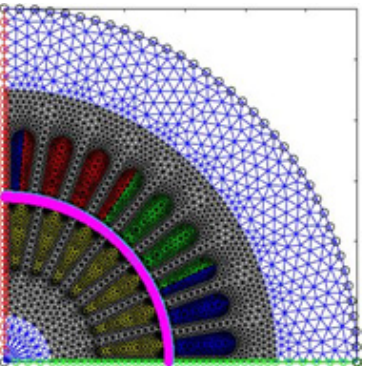
Figure 3. Mesh image of the three-phase squirrel cage induction motor in MATLAB. Table 1. Specifications of the three-phase squirrel cage induction motor.